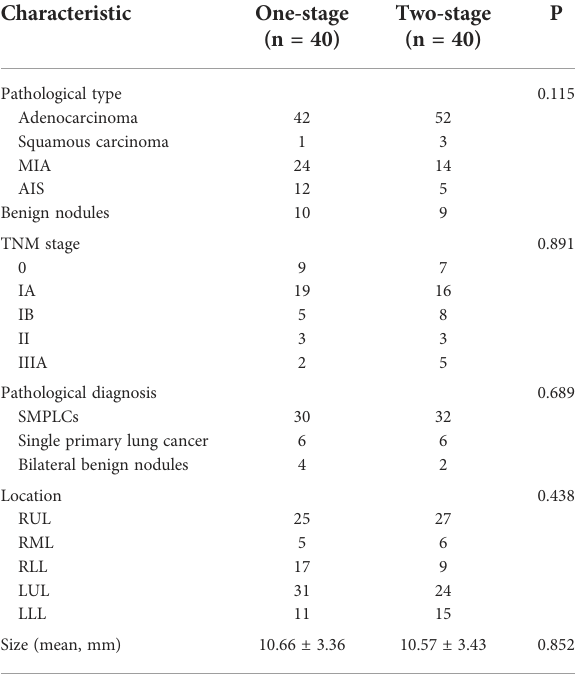
TABLE 4 Comparison of patients ’ pathological characteristics of the two groups. Characteristic